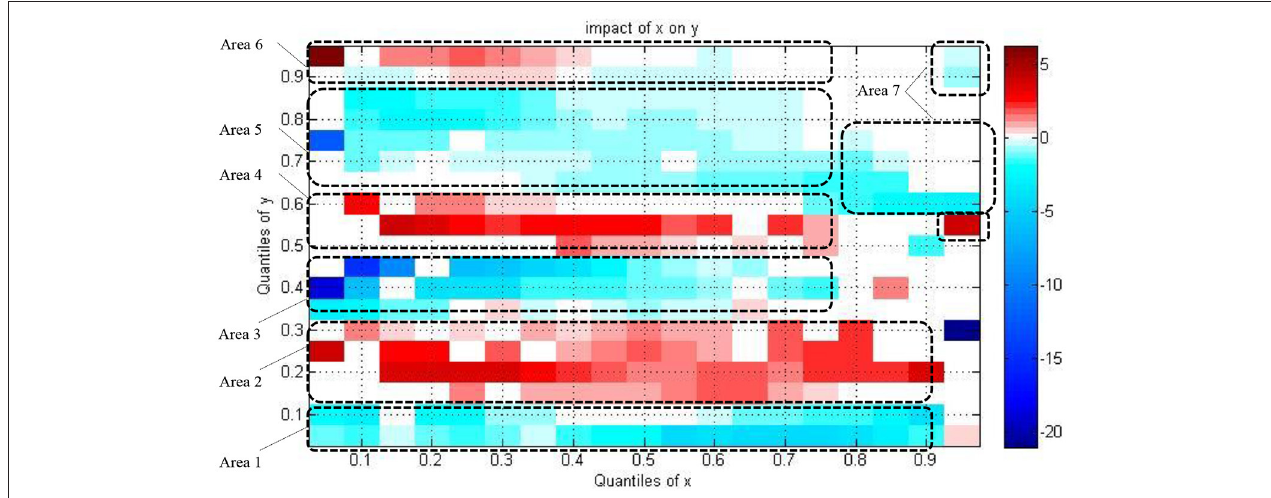
FIGURE 2 | The estimation of the slope coefficient two-dimensional diagram. X indicates healthcare expenditure; Y indicates economic growth.